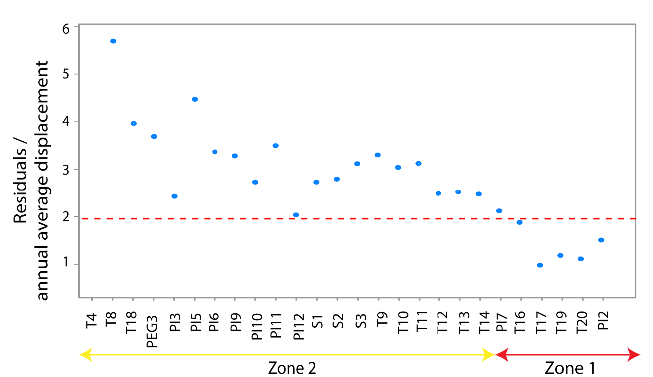
Figure A5. Residuals compared to the horizontal annual average displacement for the 26 geodetical observation points.